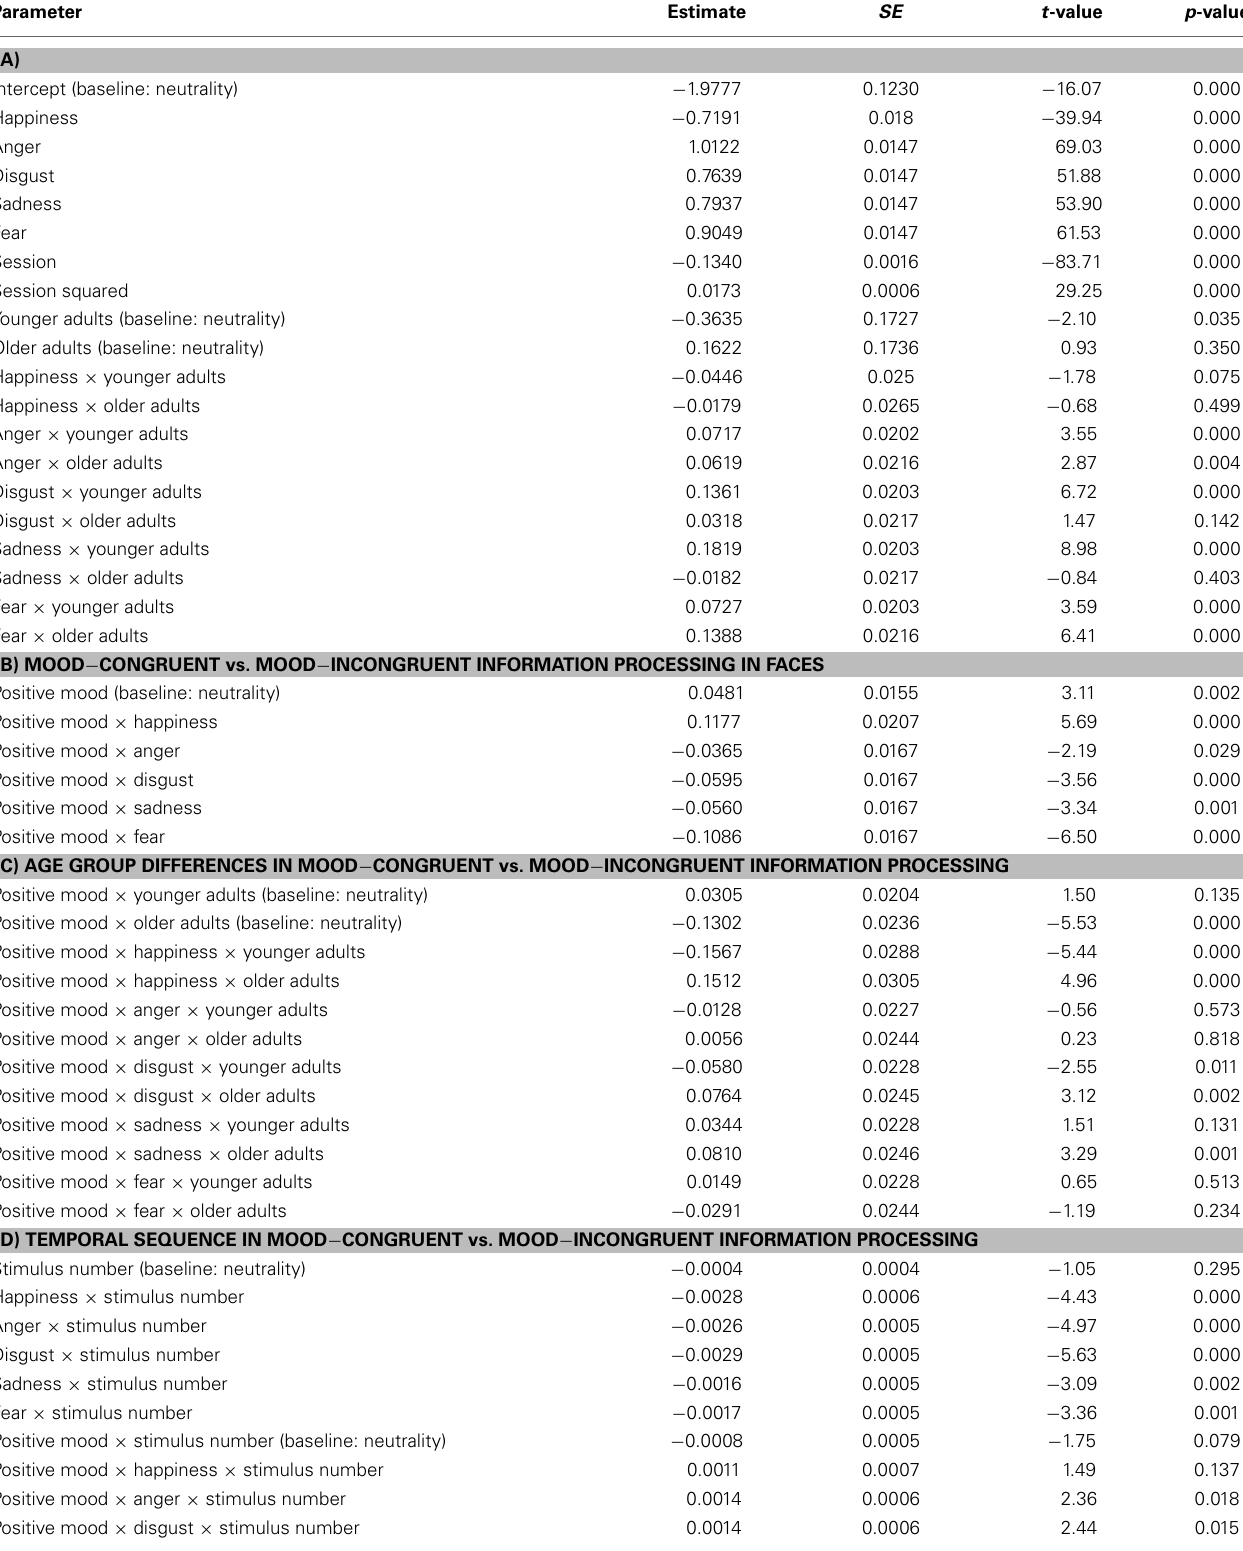
Table 1 | Results of a crossed random effects analysis predicting the likelihood of perceiving an (additional but the primary) emotional expression in a face by type of emotion, positive mood, session number, stimulus number, and age group.